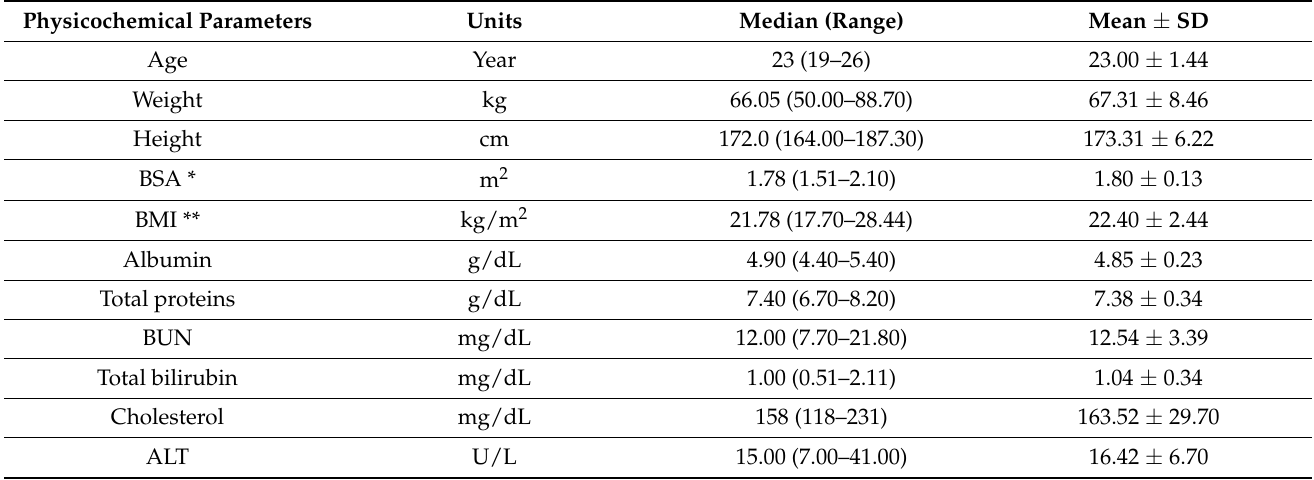
Table 1. Demographic information of study subjects ( n =